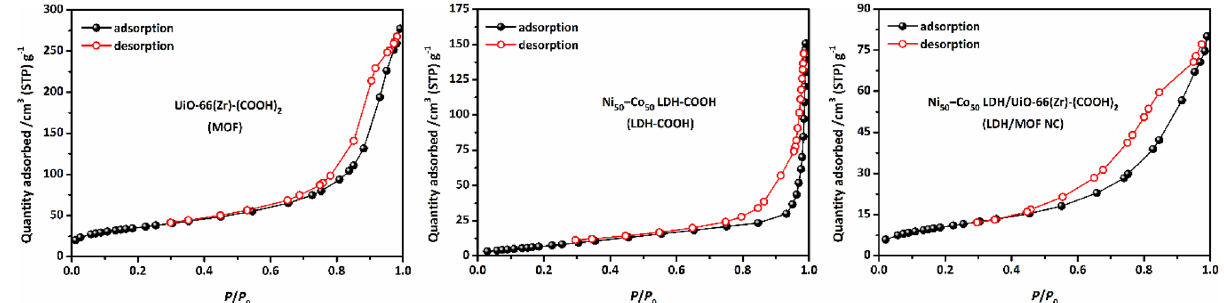
Figure 4. N 2 adsorption–desorption isotherms of the